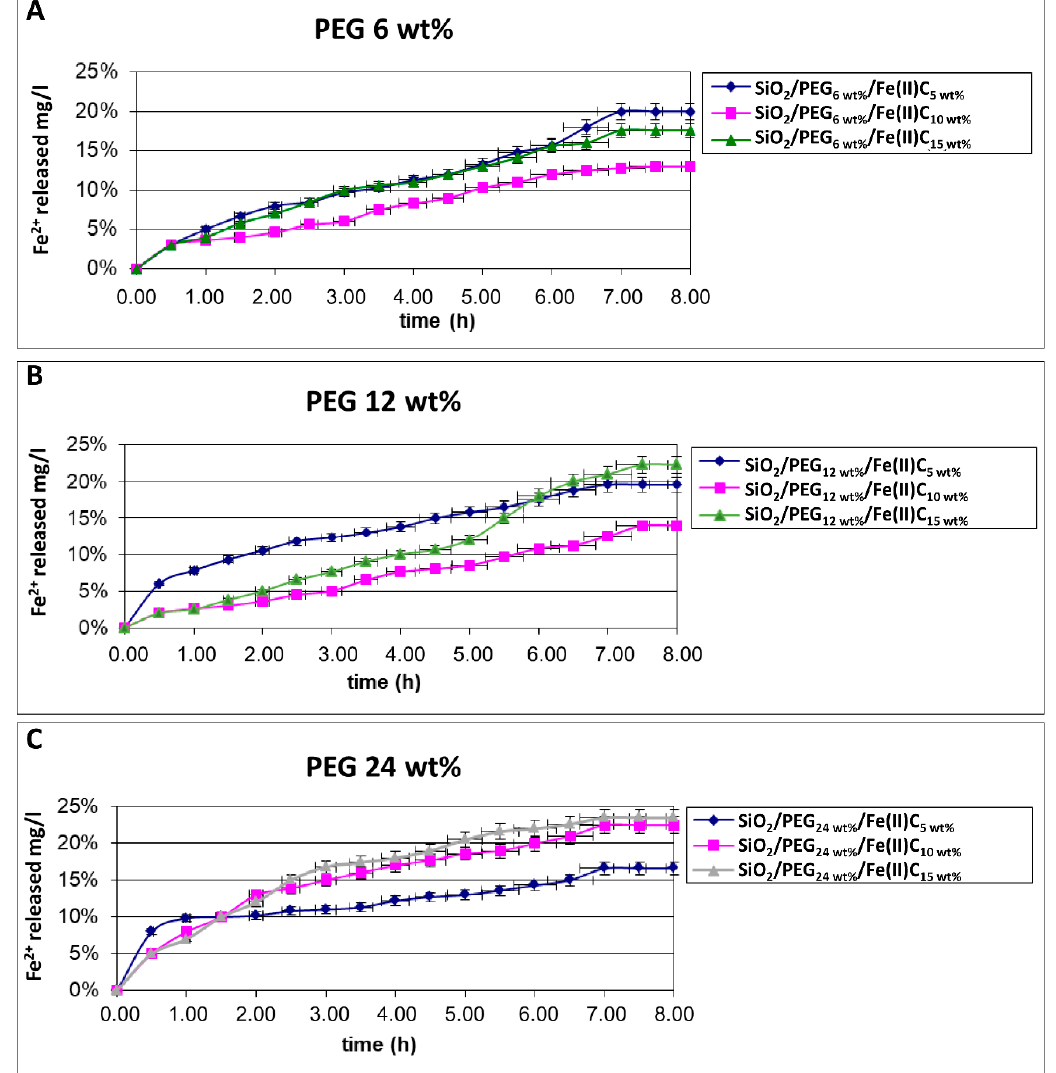
Figure 4. Time-dependent drug release plot for ( A ) SiO 2 /PEG 6 wt% /Fe(II)C 5 wt% ; SiO 2 /PEG 6 wt% /Fe(II)C 15 wt% ; SiO 2 /PEG 6 wt% /Fe(II)C 20 wt% ; ( B ) SiO 2 /PEG 12 wt% /Fe(II)C 5 wt% ; SiO 2 /PEG 12 wt% /Fe(II)C 10 wt% ; SiO 2 /PEG 12 wt% /Fe(II)C 15 wt% ; ( C ) SiO 2 /PEG 24 wt% /Fe(II)C 5 wt% ; SiO 2 /PEG 24 wt% /Fe(II)C 10 wt% ; SiO 2 /PEG 24 wt% /Fe(II)C 15 wt% .